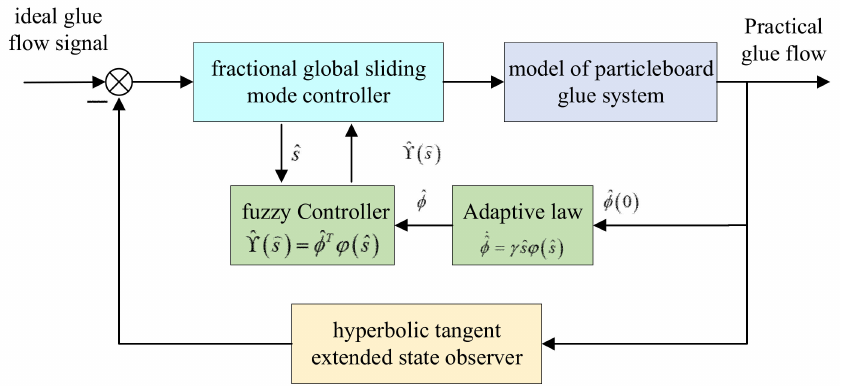
Figure 4. The structure diagram of adaptive fuzzy fractional order global sliding mode control based on hyperbolic tangent extended state